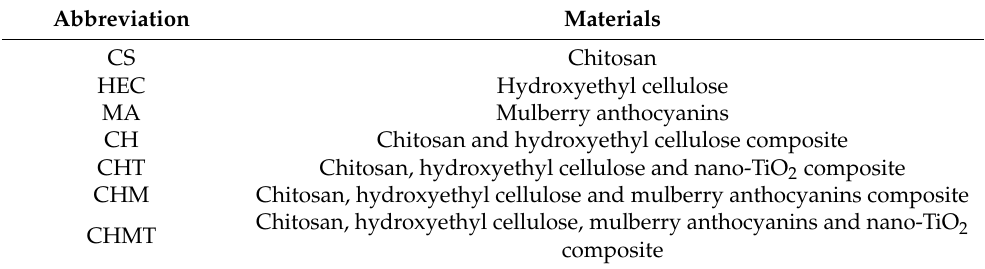
Table 1. The materials used for the 3D-printed bilayer